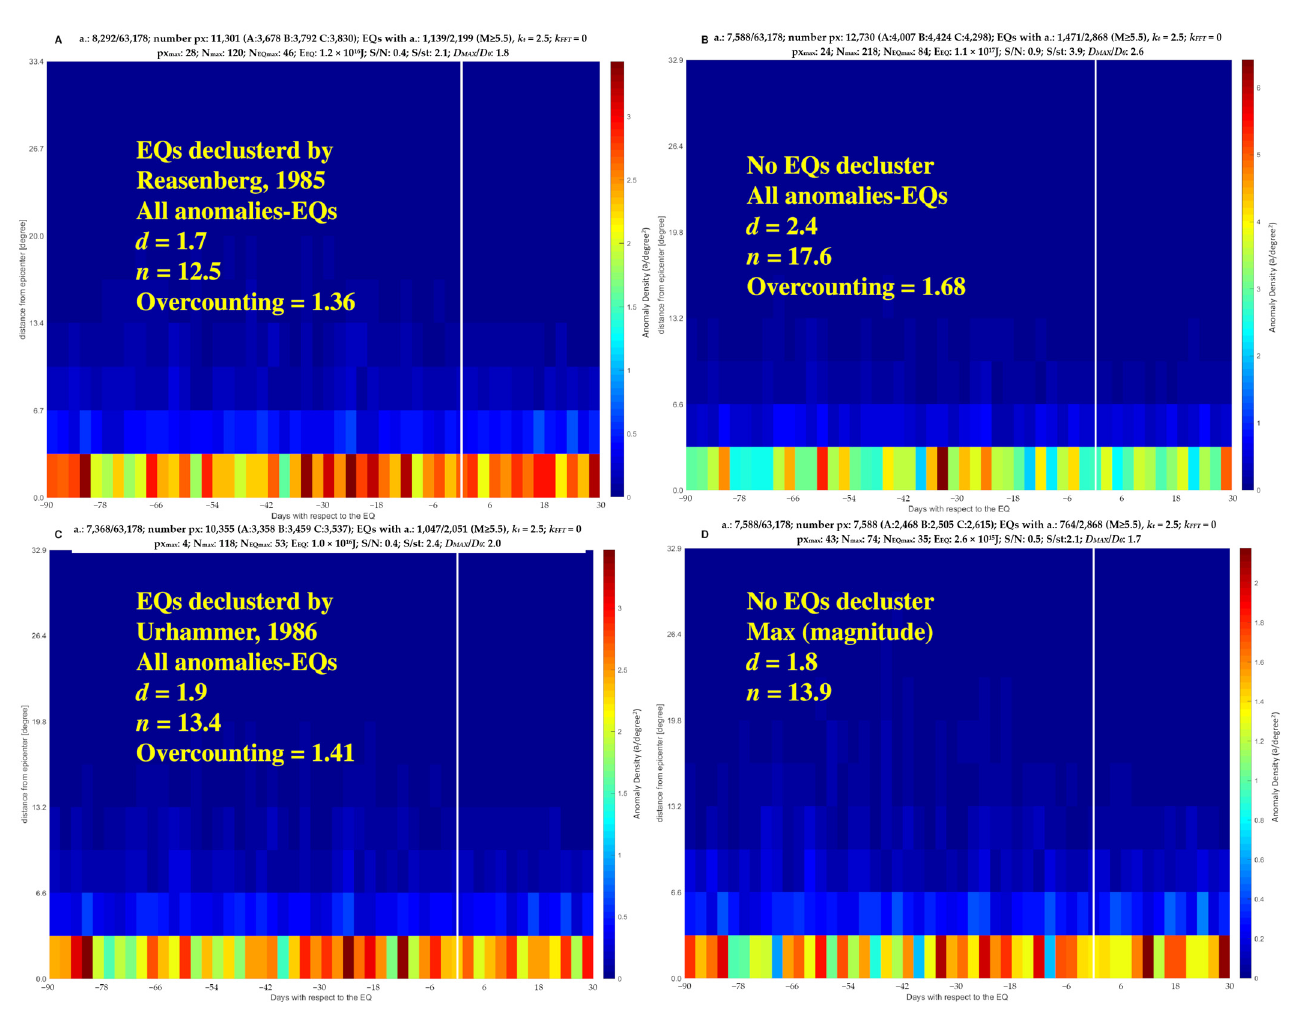
Figure A1. Comparison of the results of the Worldwide Statistical Correlation using two different declustering methods or by not declustering the catalog. The Swarm magnetic field data investigated from 90 days before the earthquake until 30 days after it are used for this example. The earthquake catalog has been declustered with: ( A ) Reasenberg, 1985 [35]; ( C ) Urhammer, 1986 [55]. The earthquake catalog used for the WSC of ( B , D ) has not been declustered. In ( A – C ), all anomalies have been assigned to any compatible earthquake, and the overcounting factor (the number of links between the anomalies and EQs divided by the number of anomalies with EQs) has been reported, while, in ( D ), each anomaly has been connected only to the higher magnitude earthquake among the possible ones (thus, there is no